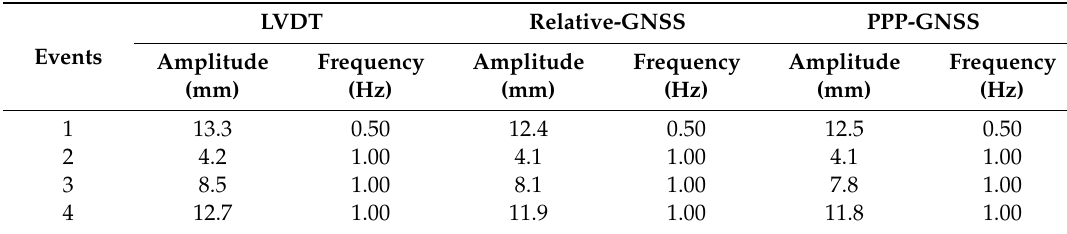
Table 4. Summary of characteristics of the four